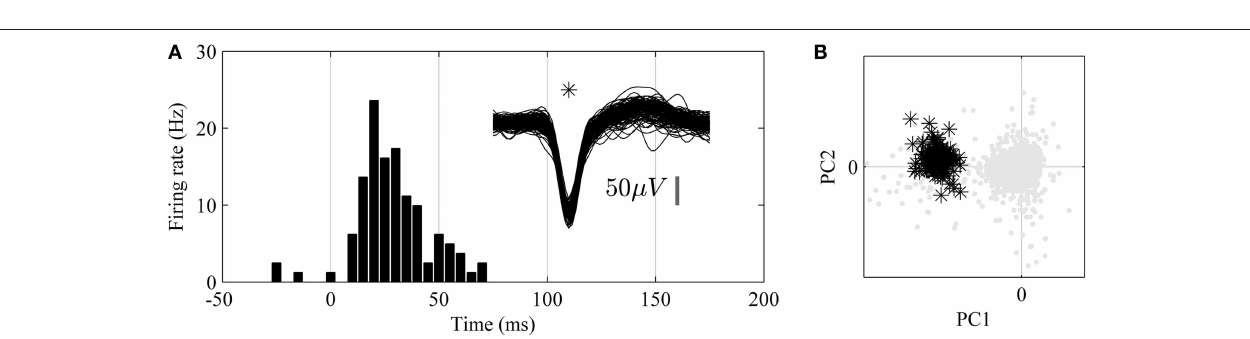
FIGURE 5 | Analysis of unit responses to tactile stimulation of the hind paw in awake, non-restrained rat. (A) Peristimulus-Time-Histogram (PSTH) for an identified single-unit (superimposed 1.6ms long spike wave-forms for the unit are shown to the right, n = 150 ). (B) Principal component analysis (PCA). Note that the single unit (black stars) is well isolated from the background noise (gray dots) in the principal component (PC1 and PC2) feature space.